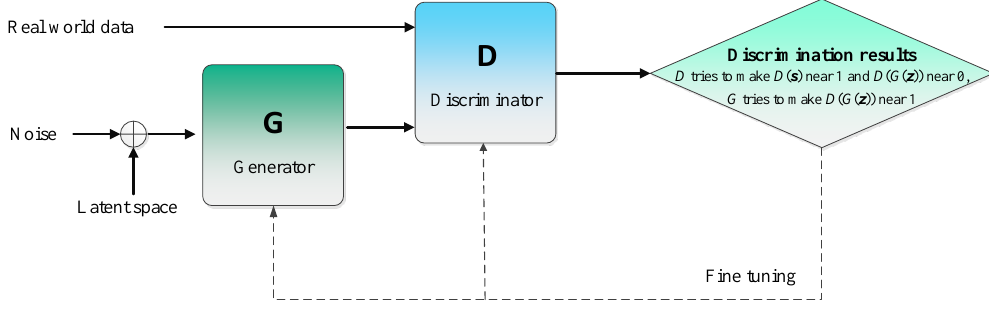
Figure 3. The general GANs